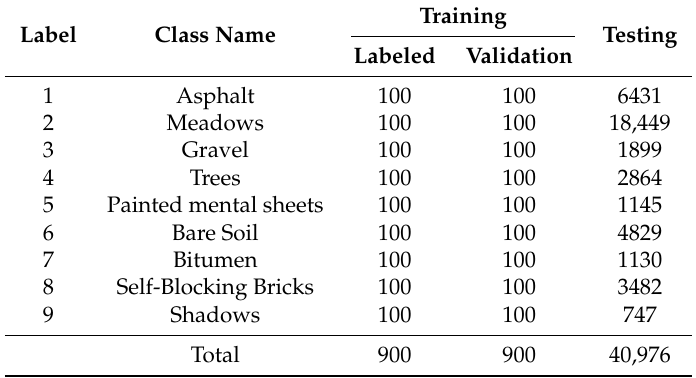
Table 4. Number of training and testing samples in Indian Pines dataset.